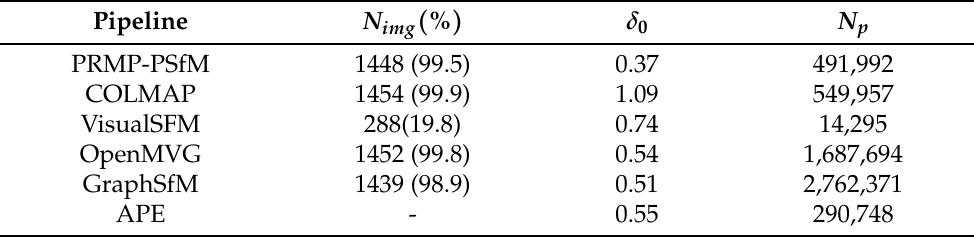
Table 4. Numerical comparison on Church dataset for different SfM pipelines. N img is the number of orientated images in the final reconstruction results, and the % values refer to the number of orientated images compared with that of the input images, δ 0 is the mean projection error in pixels, N p is the number of tie points, and “-” indicates that the corresponding items are unavailable.